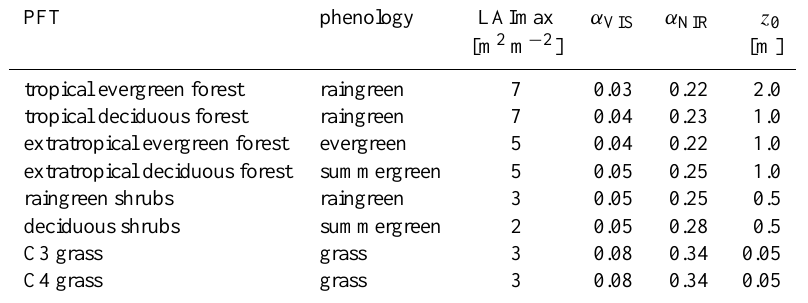
Table 1. Physical properties and phenology type of each plant functional type (PFT), i.e. LAImax: maximum value of the leaf area index; α VIS : albedo in the visible solar spectrum; α NIR : albedo in the near infrared solar spectrum; z 0 : roughness length of vegetation. PFT